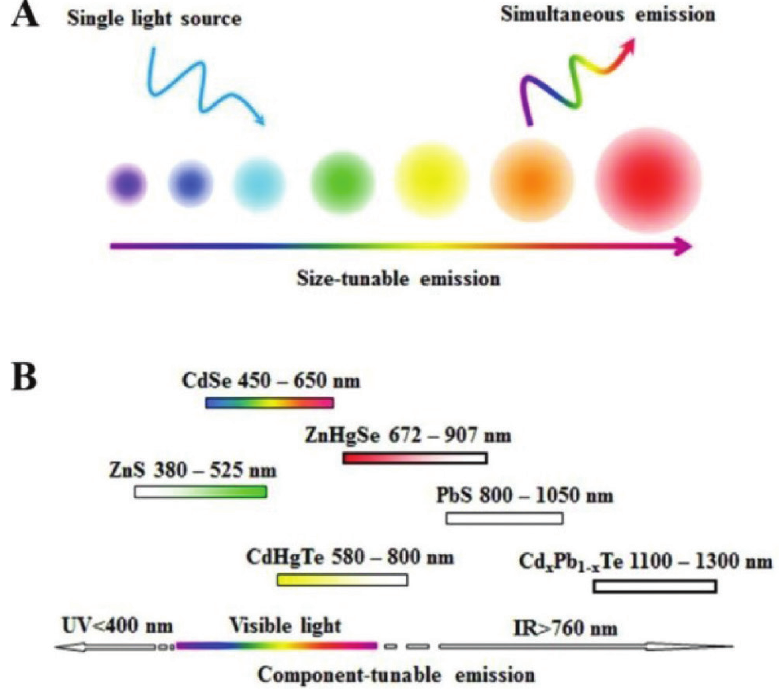
Figure 2: Physical properties of QDs. (a) The fluorescence emission spectrum of QDs is adjustable, and multiple QDs can be excited by a single light source. (b) The emission spectrum of QDs can range from near-infrared region to the ultraviolet region. Reprinted image with permission from Ref. [30], Copyright 2015, American Chemical